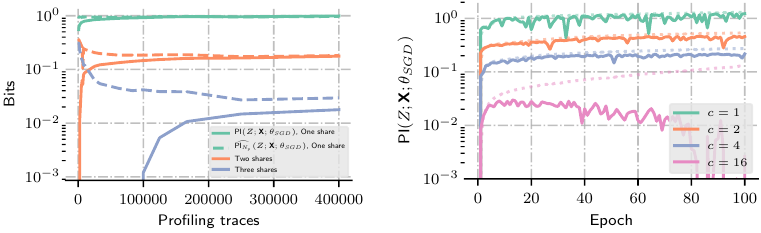
Figure 2: Left: learning curve of Experiment 4 on masking. Right: results of Experiment 5 on